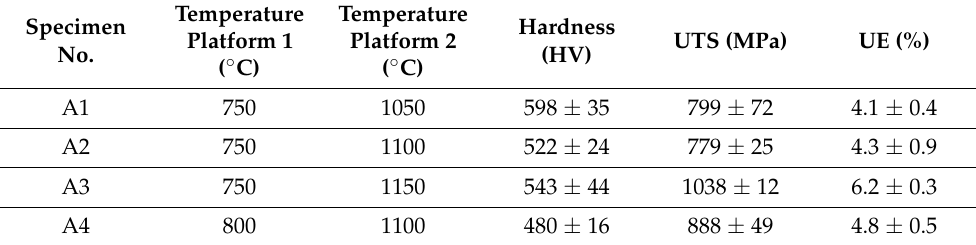
Table 6. Microhardness, ultimate tensile strength (UTS), and uniform elongation (UE) of the speci-